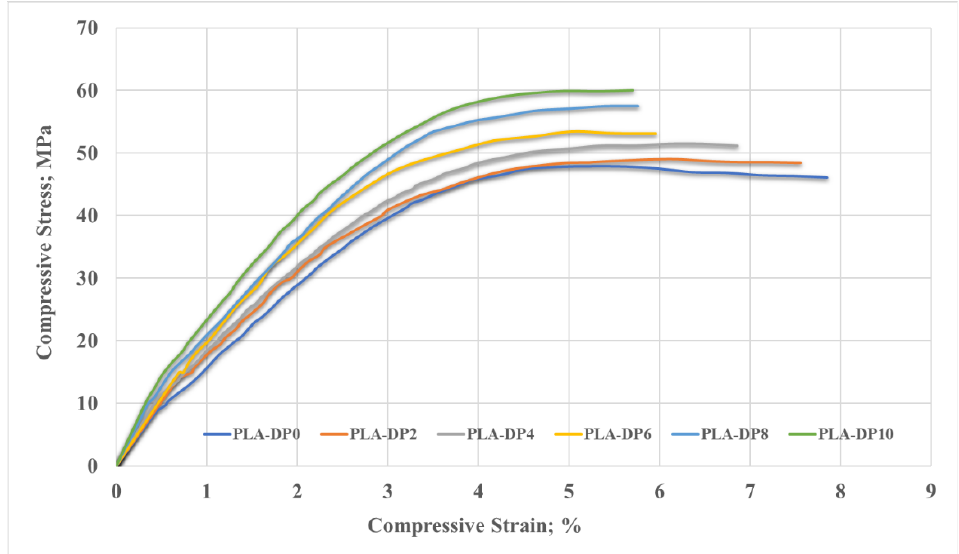
Figure 11. Compressive stress – strain curves of PLA – date pit composites.